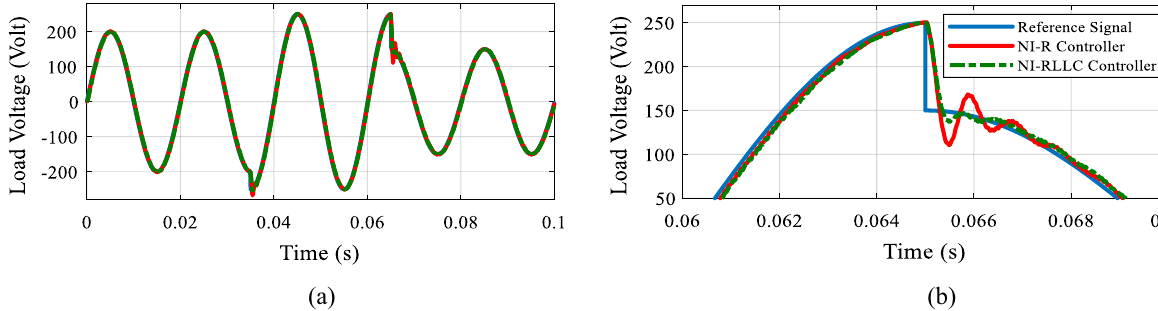
Fig. 9 Performance check for changing reference value a normal view b zoomed